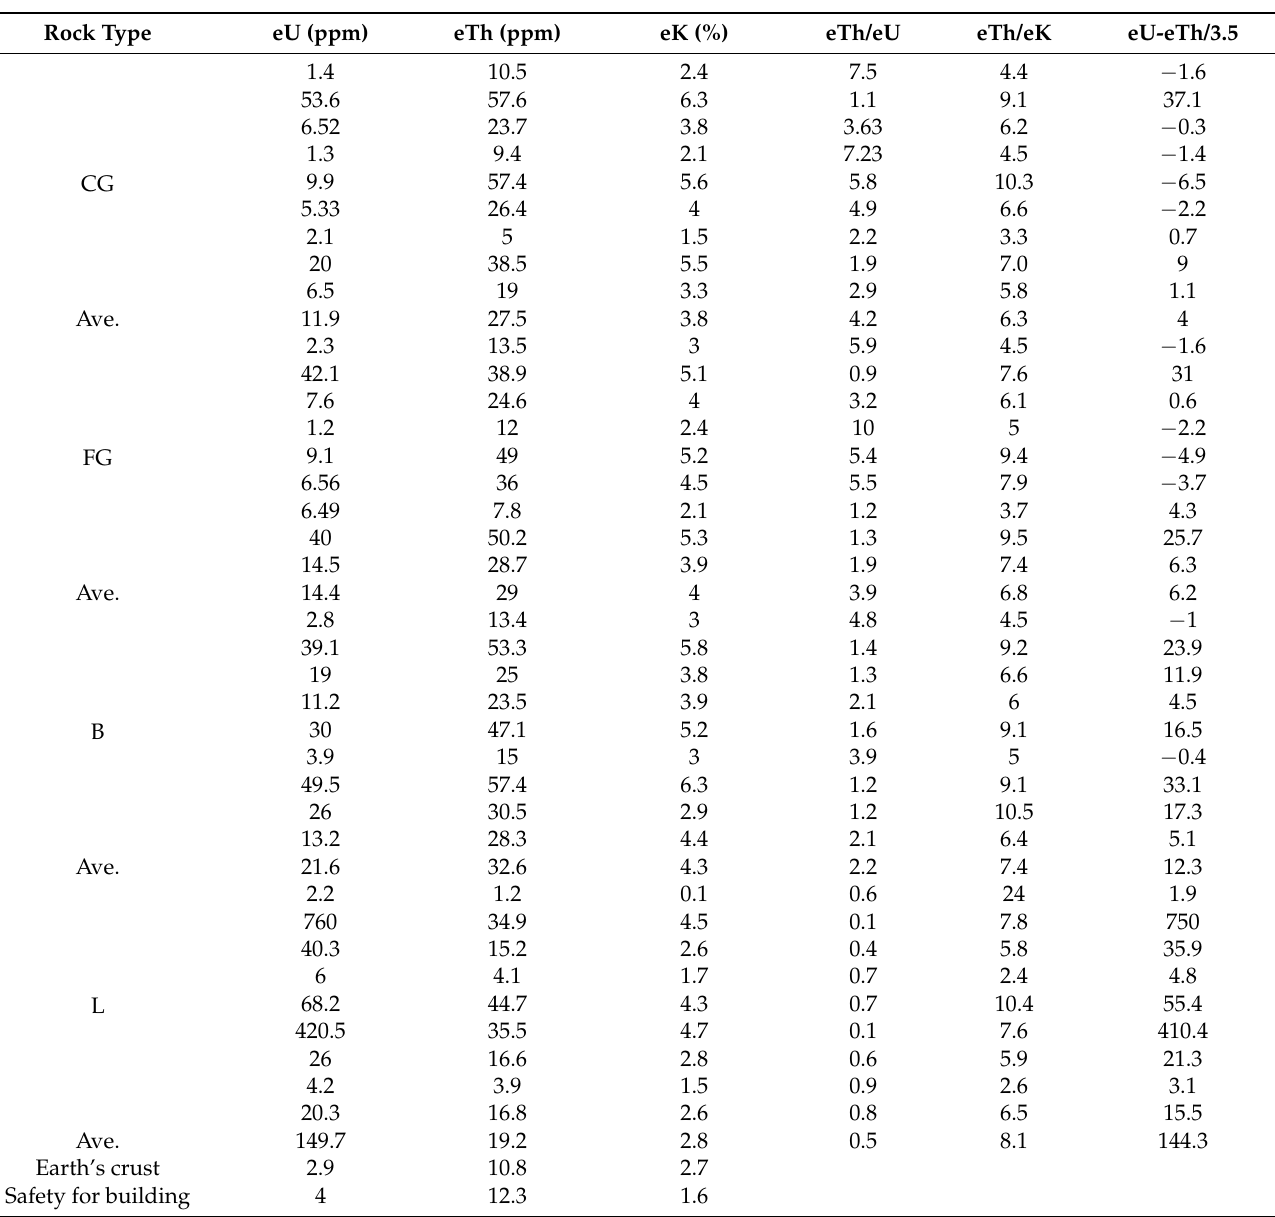
Table 2. Values of eU (ppm), eTh (ppm), and K (%), as well as eTh/eU and eTh/K ratios and (eU- eTh/3.5) parameter for the Sol Hamed granitic